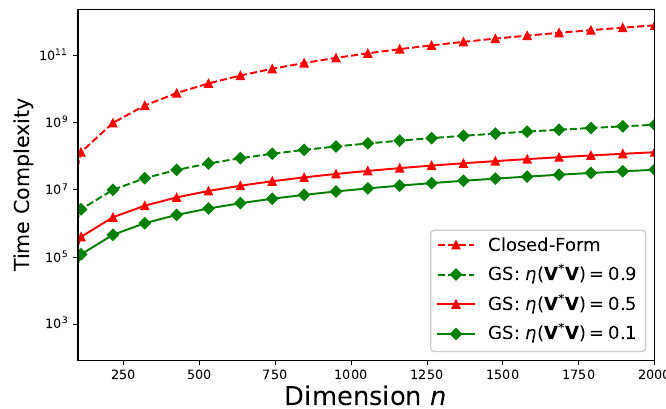
Figure 11. Time-complexity versus n for V with different spectral radii subject to (cid:101) = 10 − 10 for an